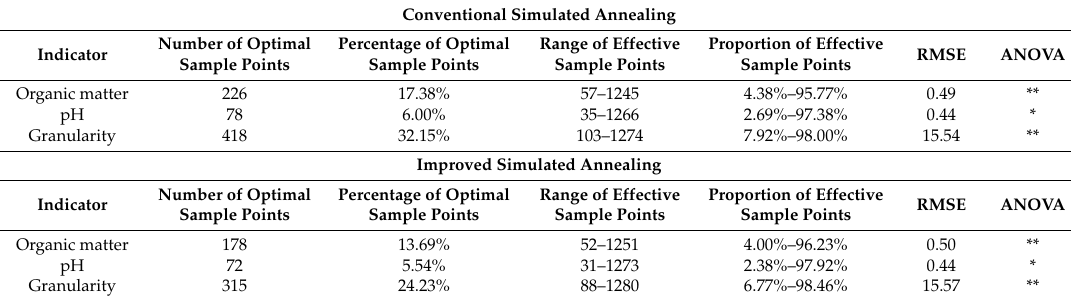
Table 1. Comparison of sample point optimization concerning the three soil properties using conventional and improved simulated annealing (SA).